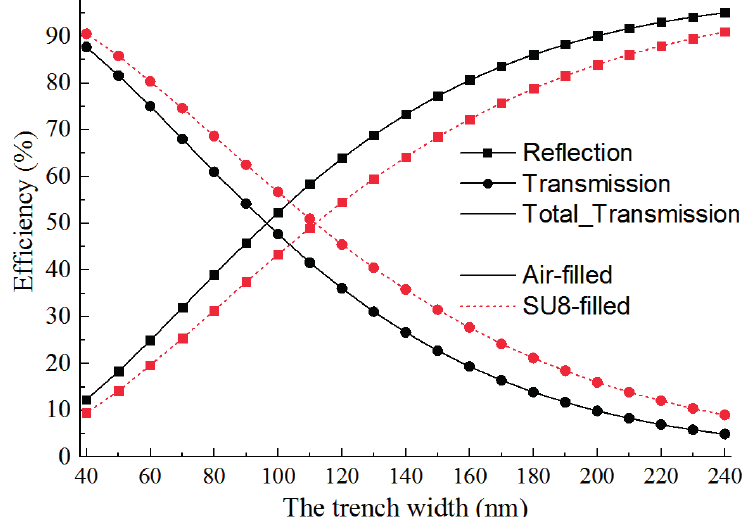
Figure 11. Splitting efficiency as a function of trench width. A 50%:50% splitting ratio is achieved with 96 nm air-trench width or 112 nm SU8-trench width.